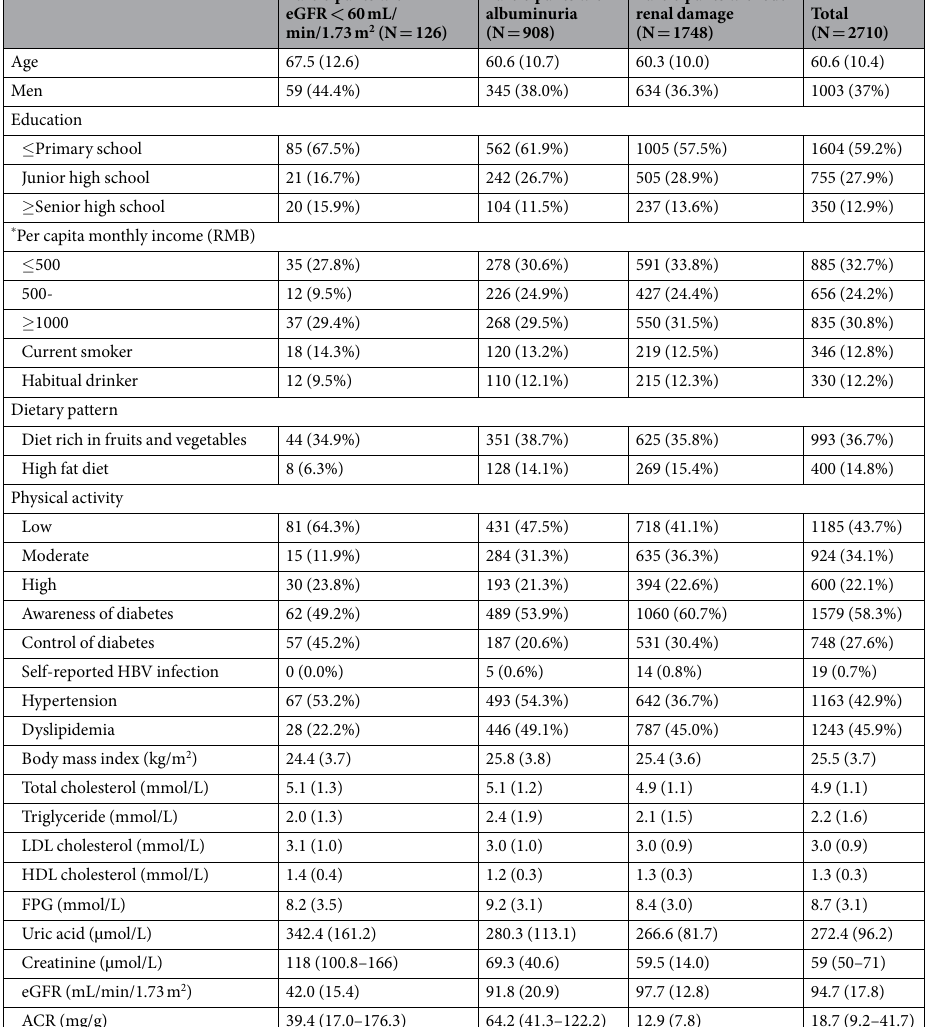
Table 3. General characteristics of participants with diabetes according to indicators of renal damage. Note: Data were n (%), mean (standard deviation) or median with interquartile range, as appropriate. Abbreviations: DKD, diabetic kidney disease; HBV, hepatitis B virus; LDL, low density lipoprotein; HDL, high density lipoprotein; eGFR, estimated glomerular filtration rate; FPG, fasting plasma glucose; ACR, albumin: creatinine